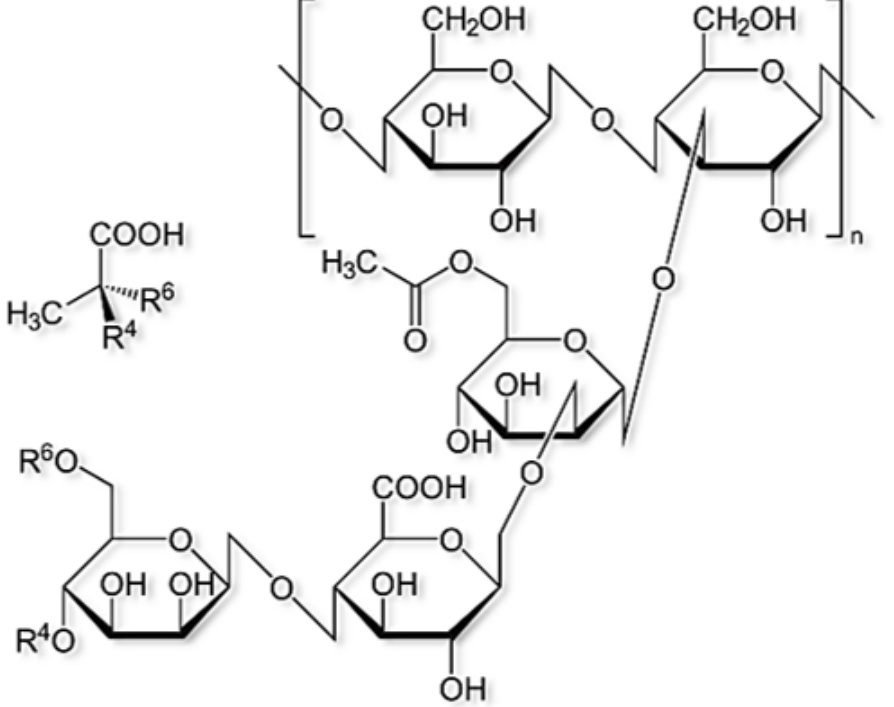
Figure 9. An illustration of chemical structure of xanthan gum (Reprinted from Lwisa, Essa, 2021